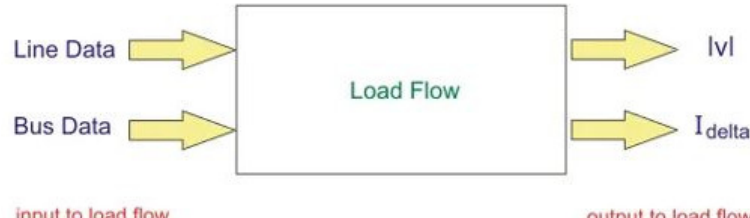
Figure 1. Schematic of the power flow